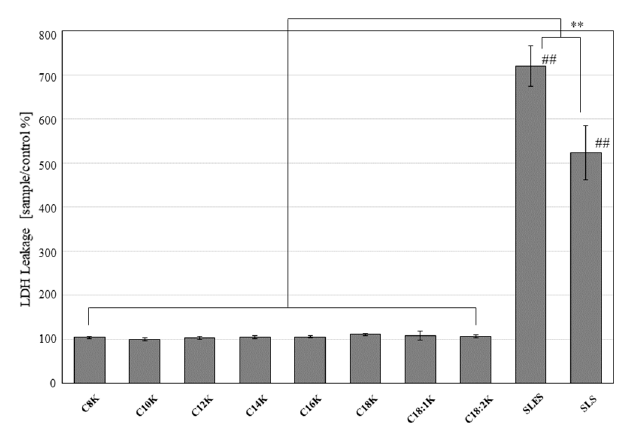
Figure 2. LDH leakage of BALB/3T3 cells treated with 0.5 mM fatty acid potassium, SLES, or SLS for 5 min. Untreated cells were used as the control. The percentage LDH leakage was calculated relative to the control value. Results are expressed as mean ± standard deviation (SD) values ( n = 8). ** p < 0.01; ## p < 0.01 compared to the control.